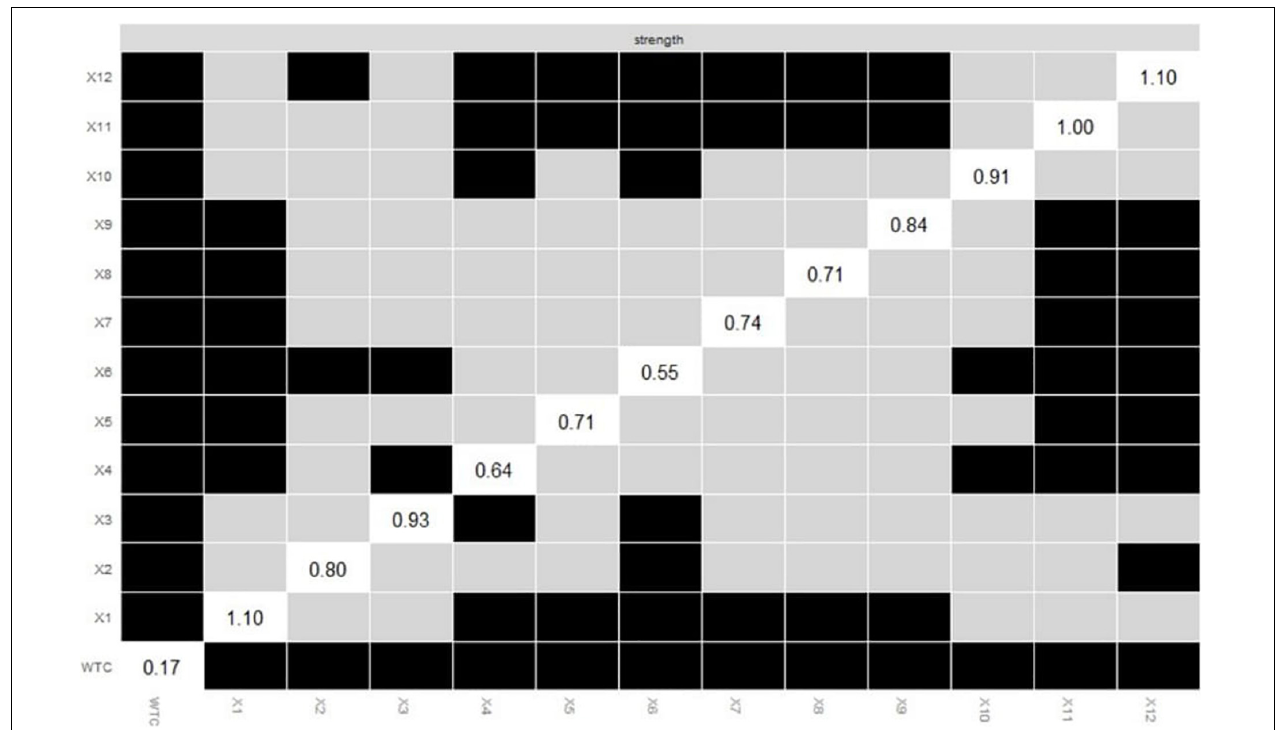
FIGURE 9 | Bootstrapped differences ( α = 0.05) between the node strengths of the thirteen variables. Gray boxes indicate nodes that do not differ significantly from one another. Black boxes indicate nodes that differ significantly from one another. White boxes in the centrality plot show the value of the node